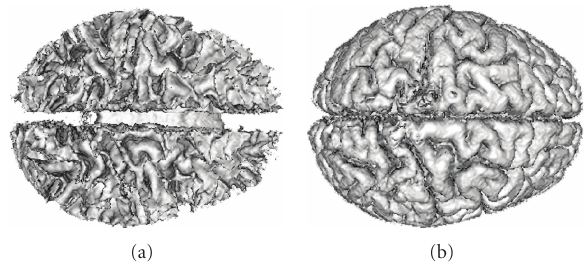
Figure 14: 3D segmentation results of (a) WM and (b) GM for the testing simulated brain.